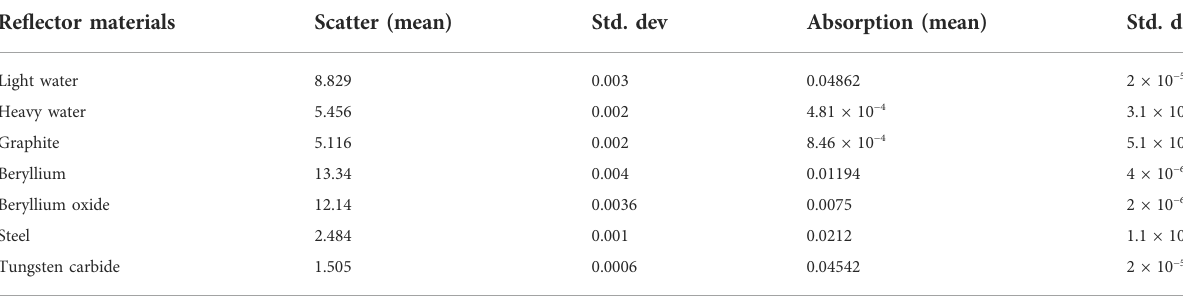
TABLE 2 The total scattering rate and absorption rate of re fl ector materials (units: reactions per source particle). Re fl ector materials Scatter (mean) Std. dev